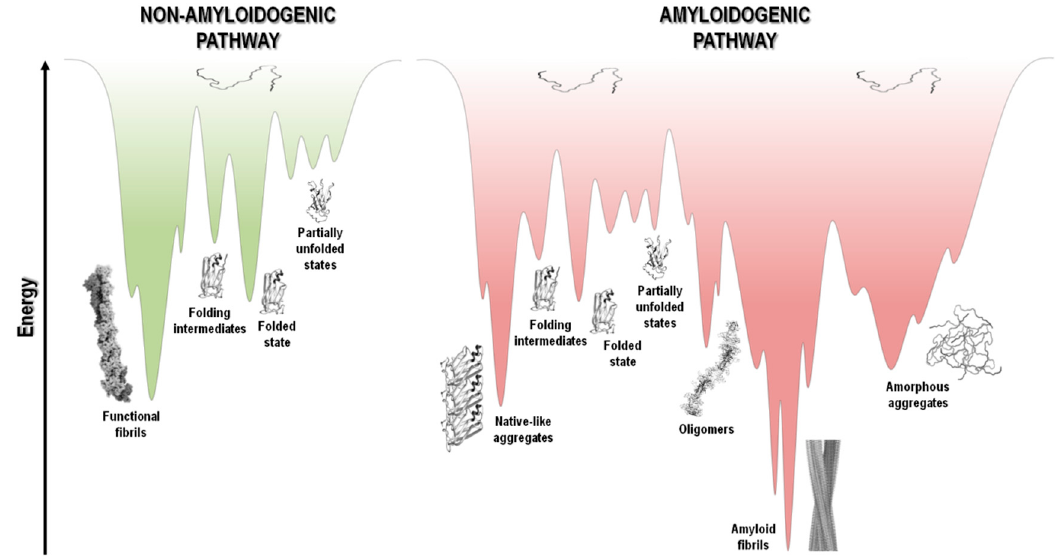
Figure 5. Schematic representation of funnel-shaped energy landscapes for protein folding (non-amyloidogenic pathway, green) and aggregation (amyloidogenic pathway, red). The surface exhibits the roughness of the protein energy landscape showing the possible conformational states adopted by the polypeptide chain. Unfolded, partially unfolded and folded species may be implicated in the aggregation landscape, as long as they are prone to establish intermolecular interactions and aggregate, thereby resulting in the formation of amorphous aggregates, amyloid fibrils, and native-like aggregates, respectively. Adapted from references [1,279,280].